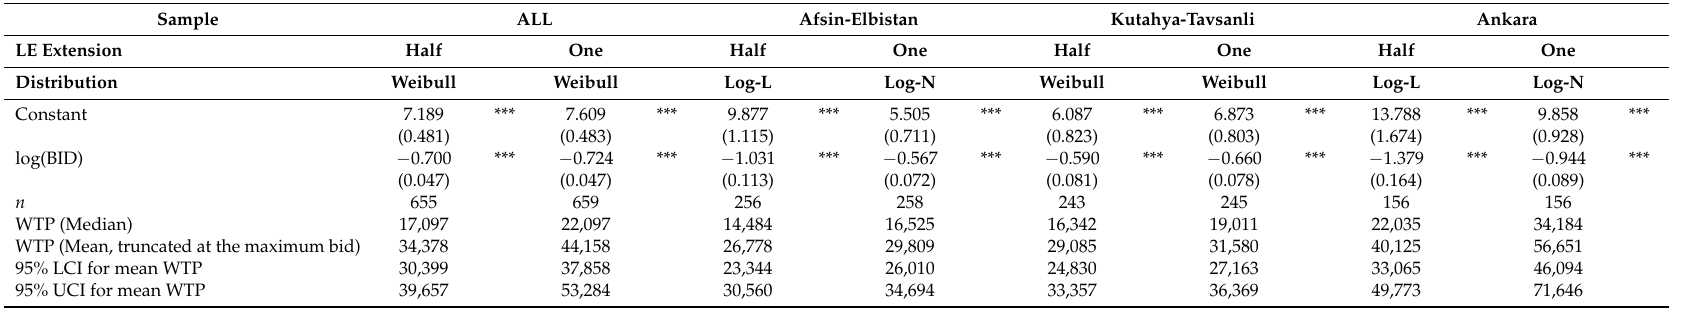
Table 6. Estimated results of base model.